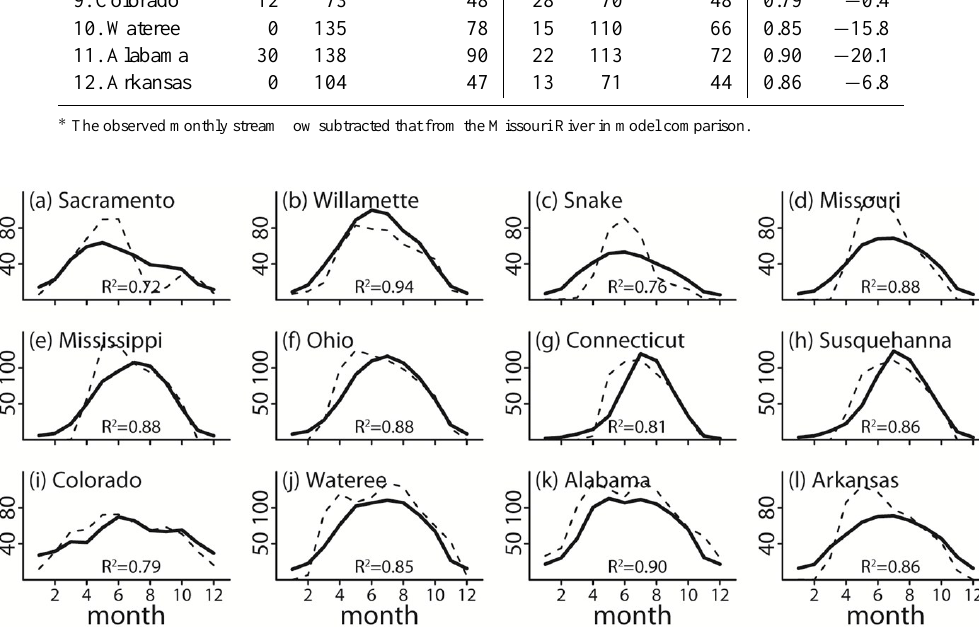
Fig. 3. Comparison between LH-simulated (solid line) and V¨or¨osmarty et al. monthly ET (V¨or¨osmarty et al., 1998) (dashed line) in the 12 river watersheds.